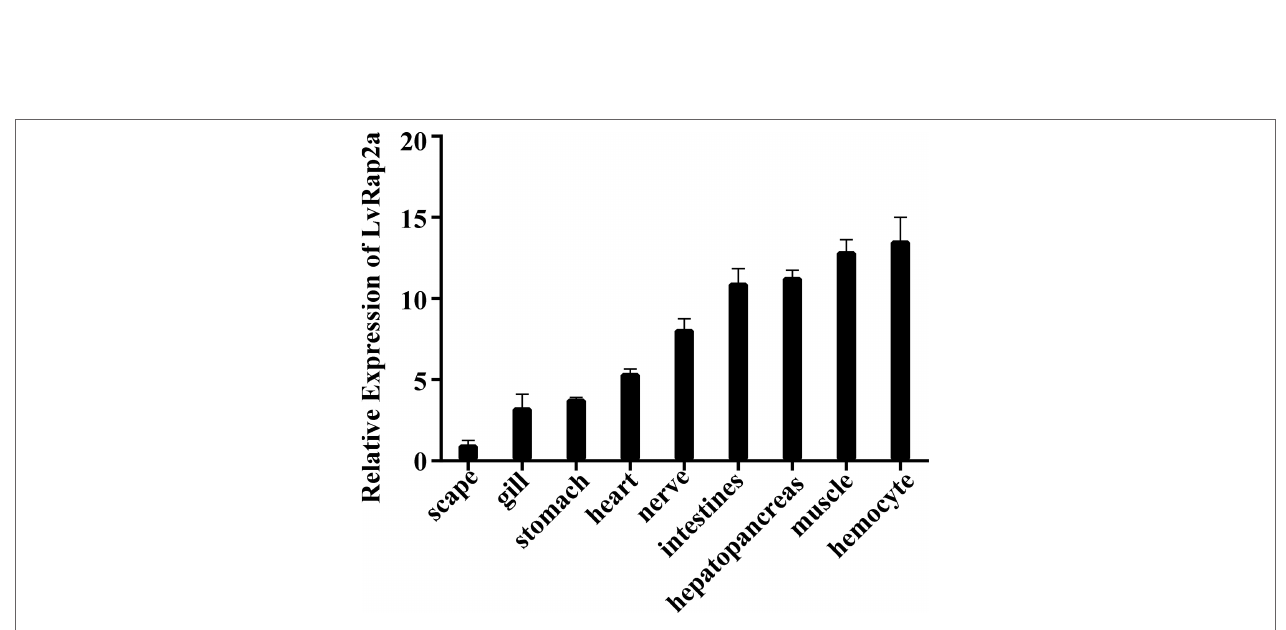
FIGURE 2 | Expression of LvRap2a in healthy shrimp detected by qRT-PCR. Expression of LvRap2a was normalized to that of EF-1 α using the Livak (2 - ΔΔ CT ) method and the data were provided as the means ± SD of triplicate assays. Expression level in the scape was set to